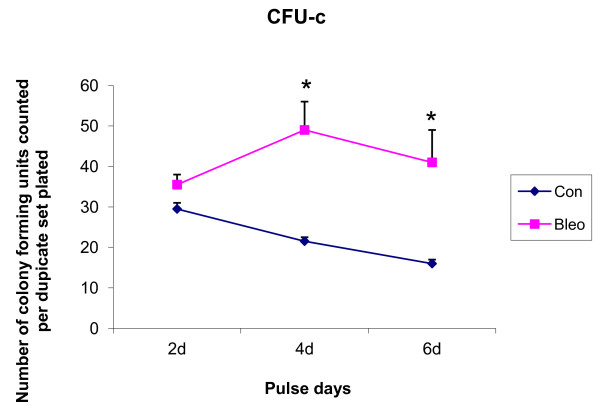
Colony forming units in lung from bromodeoxyuridine-positive cells sorted after 10 weeks of chase. Bromodeoxyuridine single-positive cells in the lung parenchyma were decreased 4.8-fold post-bleomycin, thus, the putative stem cell population appeared gradually depleted from lung upon bleomycin treatment. The 0.1 × 106 cells were plated in semi-solid methyl cellulose and CFU were counted after 14 days. All three data points (pink squares) for bleomycin-treated (Bleo) mouse lungs were significantly increased compared to the control (Con) mouse (blue diamonds). *P < 0.05 was considered statistically significant. Data were pooled from three independent experiments (n = 4 or 5 per group). Mortality was less than 2%. Averaged data are presented as mean ± SEM of three experiments. Data were collected in duplicate petri dishes for each sample.